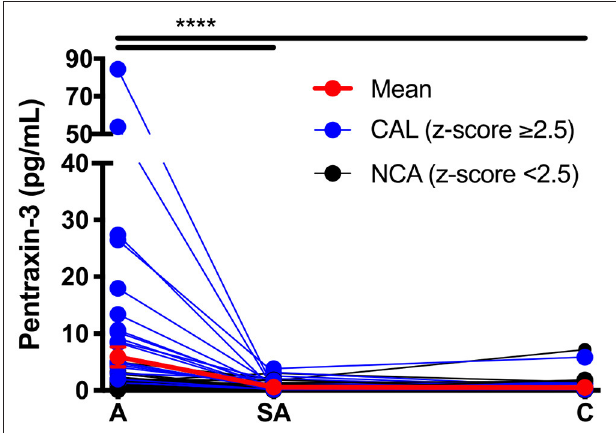
FIGURE 1 | Circulating levels of PTX-3 throughout Kawasaki disease (KD) progression. Repeated-measures ANOVA was used to compare the PTX-3 levels between the three phases of KD. The black lines track the KD patients with normal coronary artery ( n = 44), the blue lines track the KD patients with coronary artery lesion ( n = 26), and the red line tracks the mean ± SEM of all the patient serum samples ( n = 70) evaluated at each phase of the disease. A, acute ( n = 62); SA, sub-acute ( n = 65); C, convalescent ( n = 64); SEM, standard error mean. *** p ≤